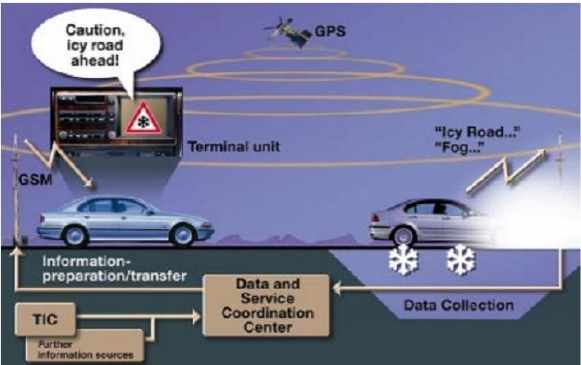
Figure 5. Different produced information by floating cars